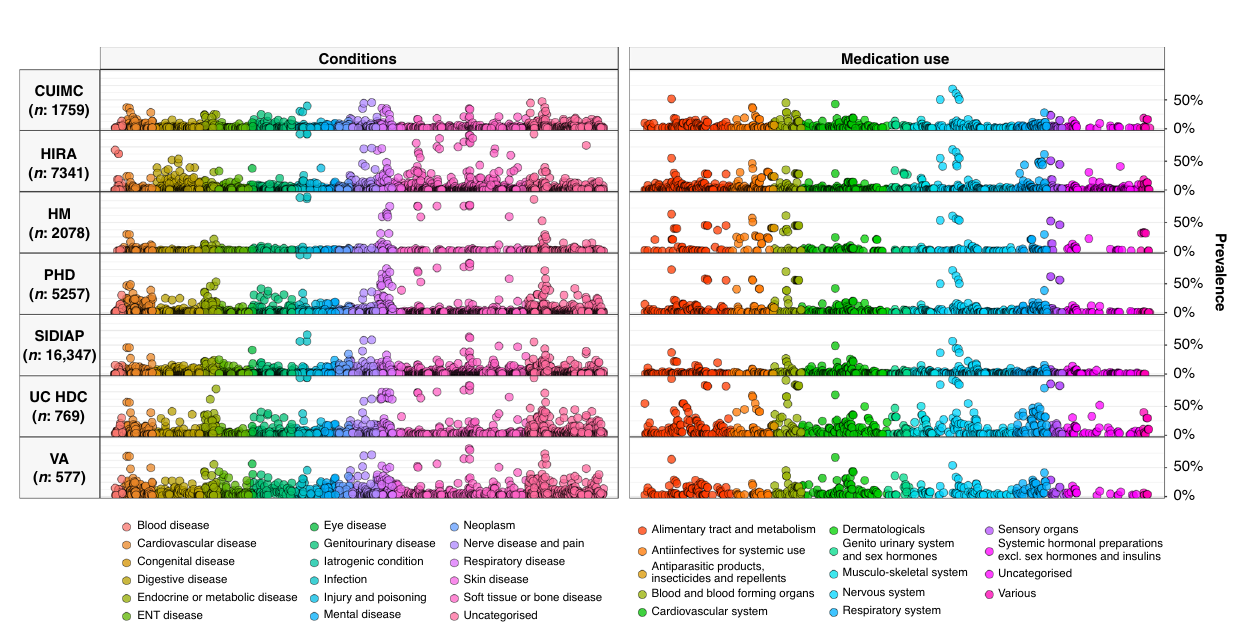
Fig. 2 Prevalence of conditions and medication use among COVID-19 patients. Individuals hospitalised with COVID-19 between December 2019 and April 2020. Conditions from up to a year prior, medication use from day of hospitalisation. Each dot represents one of these covariates with the colour indicating the type of condition/medication. CUIMC: Columbia University Irving Medical Center; HIRA: Health Insurance Review & Assessment; HM: HM Hospitales; PHD: Premier Healthcare Database; SIDIAP: The Information System for Research in Primary Care; UC HDC: University of Colorado Health Data Compass; VA OMOP: Department of Veterans